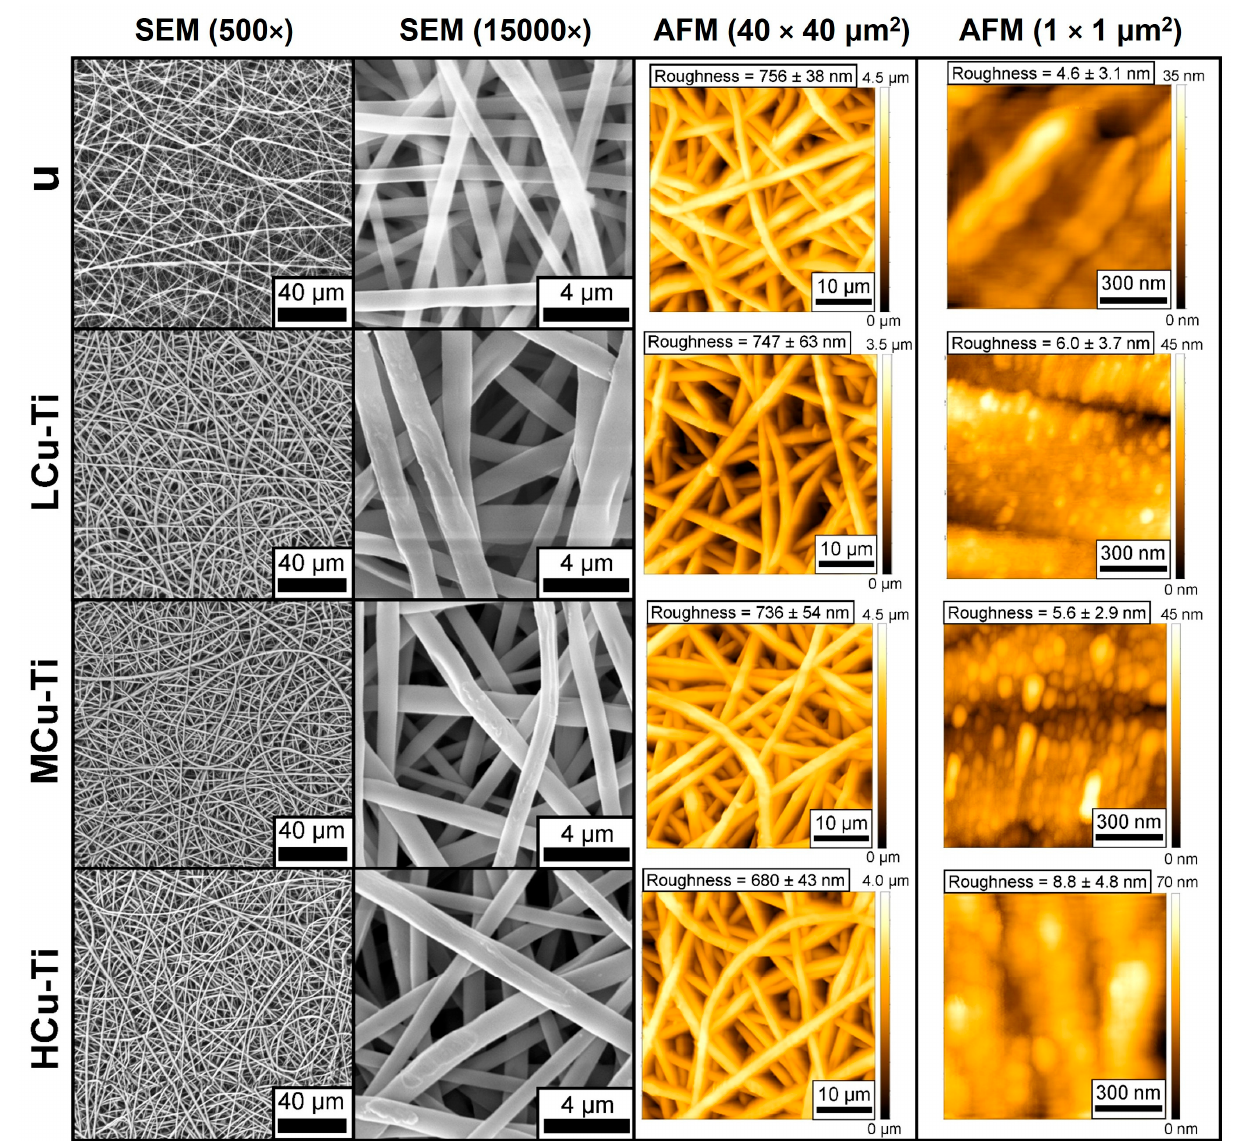
Figure 2. First column: SEM micrographs taken at 500× magni fi cation; second column: SEM micrographs taken at 15,000× magni fi cation; third column: AFM micrographs at 40 × 40 µm 2 scanning area; fourth column: AFM micrographs at 1 × 1 µm 2 scanning area of unmodi fi ed (u) and surface-modi fi ed (LCu-Ti, MCu-Ti and HCu-Ti) PLGA sca ff old samples. SEM micrographs at 500× magni fi cation and AFM micrographs at 40 × 40 µm 2 scan-